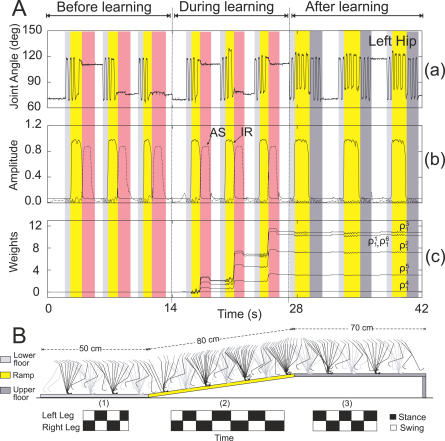
Adaptive Walking Experiments(A) The real-time data of left hip angle (a), reflexive AS and predictive IR signals (b), and plastic synapses ρ
1 (c) in three situations where there was no learning for walking up a slope at the beginning. Learning was switched on at 14 s (dashed line). After that, learning self-stabilized and ended at about 28 s (dashed line). The data was recorded while RunBot was initially walking from a lower floor (light gray areas) to an upper floor (dark gray areas) through a ramp (yellow areas). Note that red areas depict the situation where RunBot falls backward and white areas where RunBot was manually returned to the initial position. In this experiment, RunBot can manage to walk on an 8° ramp after three falls, which is approximately 14 s of learning time.(B) Stick diagram of RunBot walking on different terrains where black (gray) shows the right (left) leg. RunBot started to walk on a level floor, then on an 8° ramp, and finally it continued again on a level floor. Average walking speed was about 50 cm/s (≈2.17 leg-length/s). The interval between any two consecutive snapshots of all diagrams is 67 ms. In this walking experiment, we set gmax to 2.2. The lower diagrams show the walking step of RunBot corresponding to each walking condition above. During the swing phase (white blocks), the respective foot has no ground contact. During the stance phase (black blocks), the foot touches the ground. As a result, one can recognize the different gaits between walking on a level floor, (1) and (3), and walking up the ramp, (2).